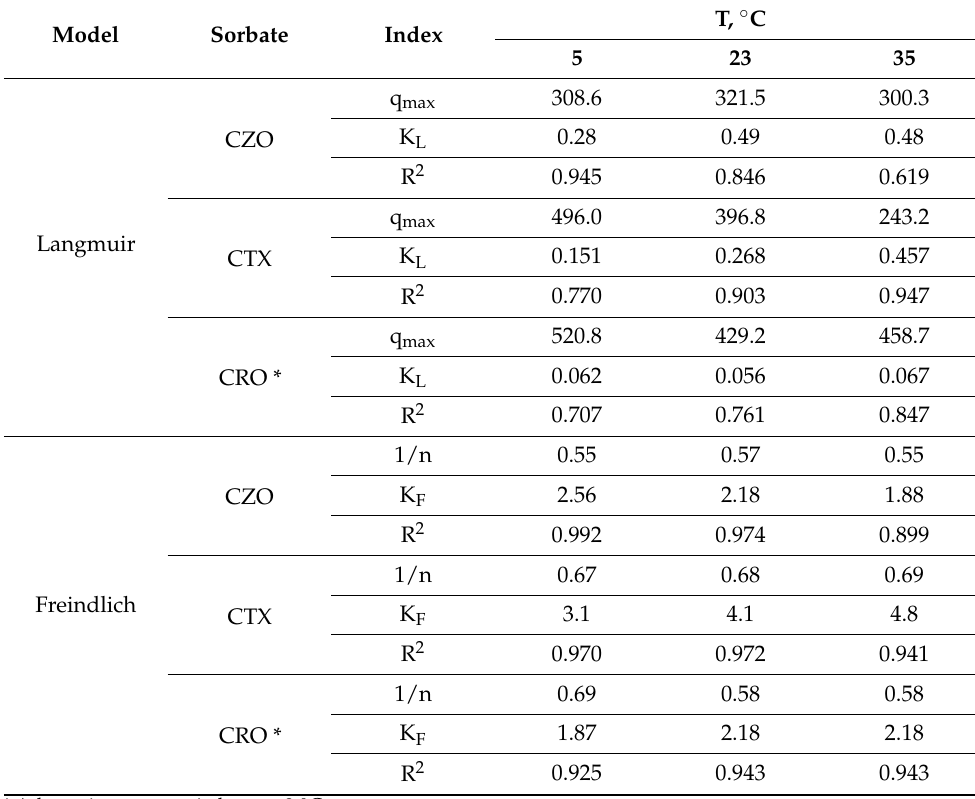
Table 2. Values of parameters of adsorption